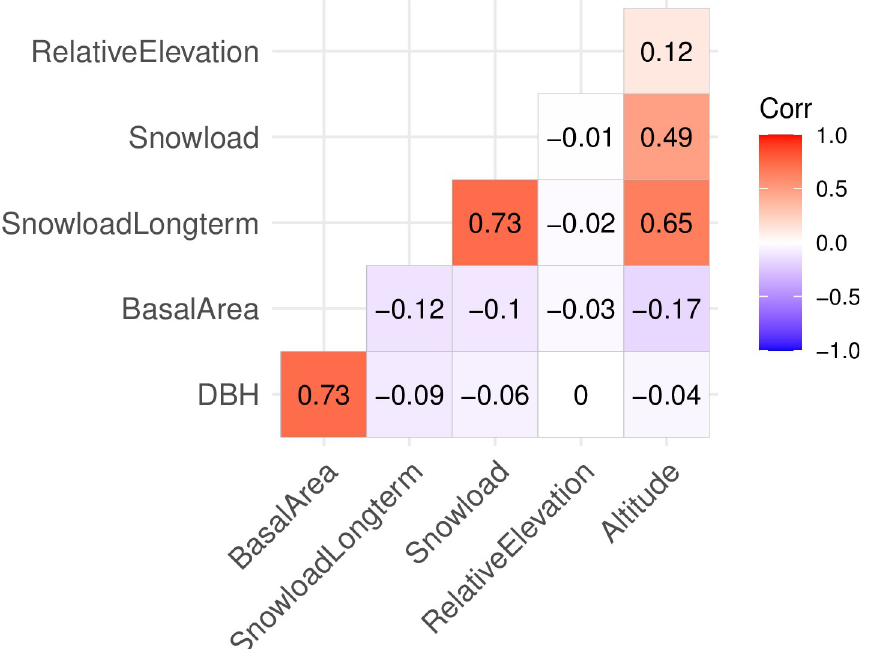
Fig 1. Correlation matrix of the continuous predictors in the final